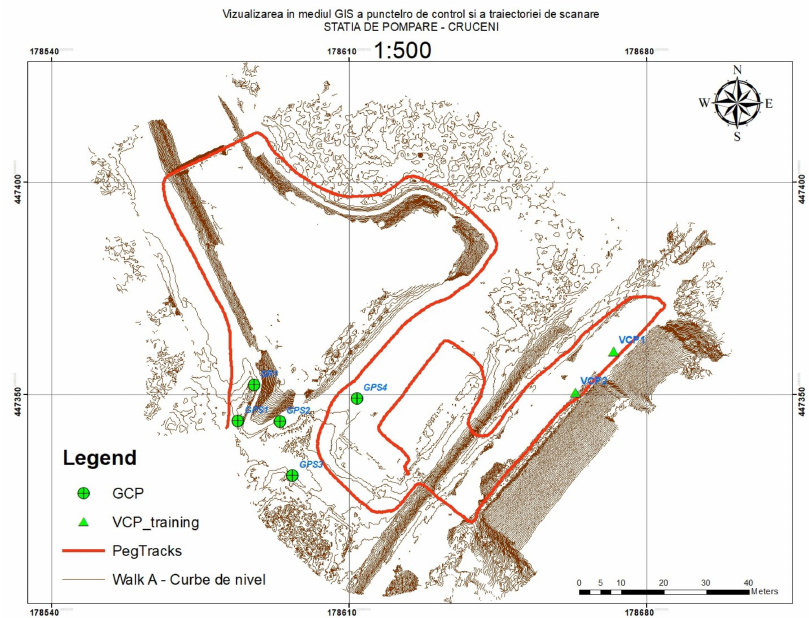
Figure 35. Visualization of LiDAR data in the GIS environment, Cruceni pumping